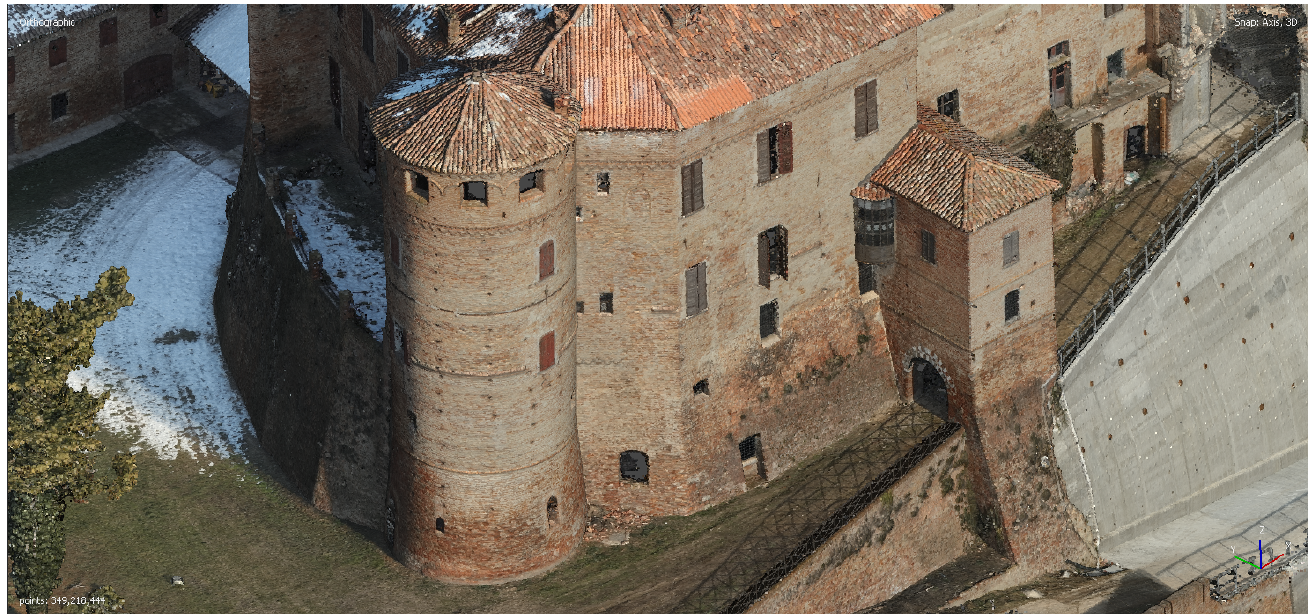
Figure 8. Photogrammetric output via Agisoft Metashape: detail on the east–west side of the castle and the circular tower (point dimension 1